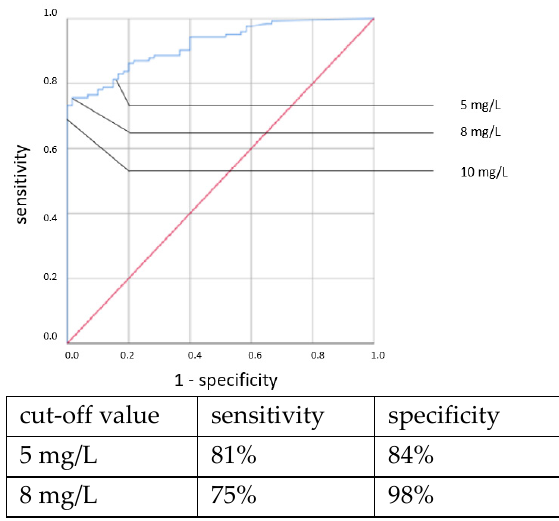
Figure 8. CRP concentration at the time of sepsis workup. Clinical LOS.